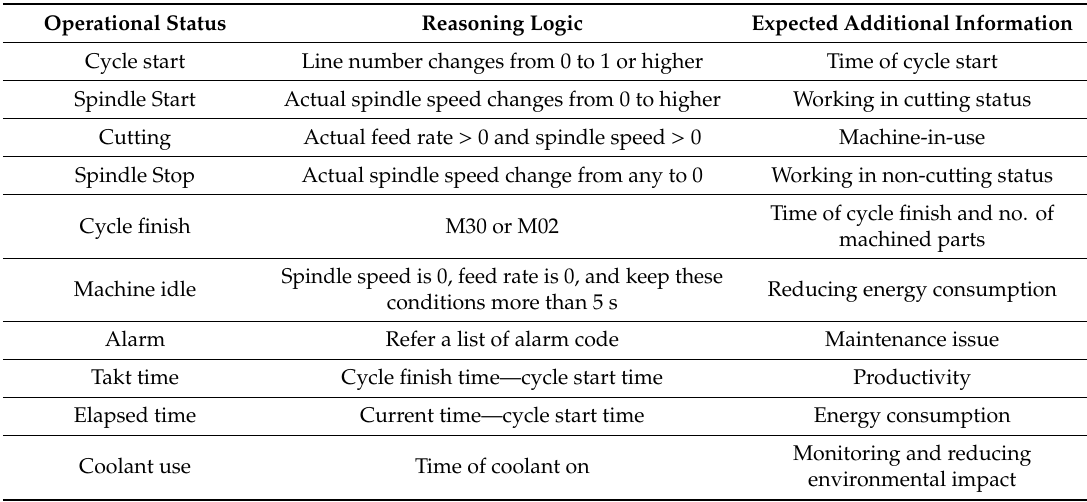
Table 4. Reasoning logics and expected additional information on the operational